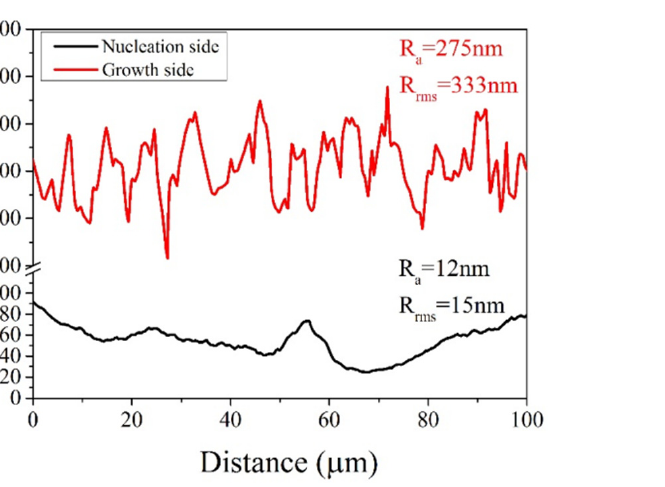
Figure 6. ( a ) SEM image of a 6 μ m thick polycrystalline diamond on a silicon substrate. ( b ) SEM image of the nucleation side of the diamond membrane, viewed through a hole in the silicon substrate. The nominal value of the hole diameter was 300 μ m.